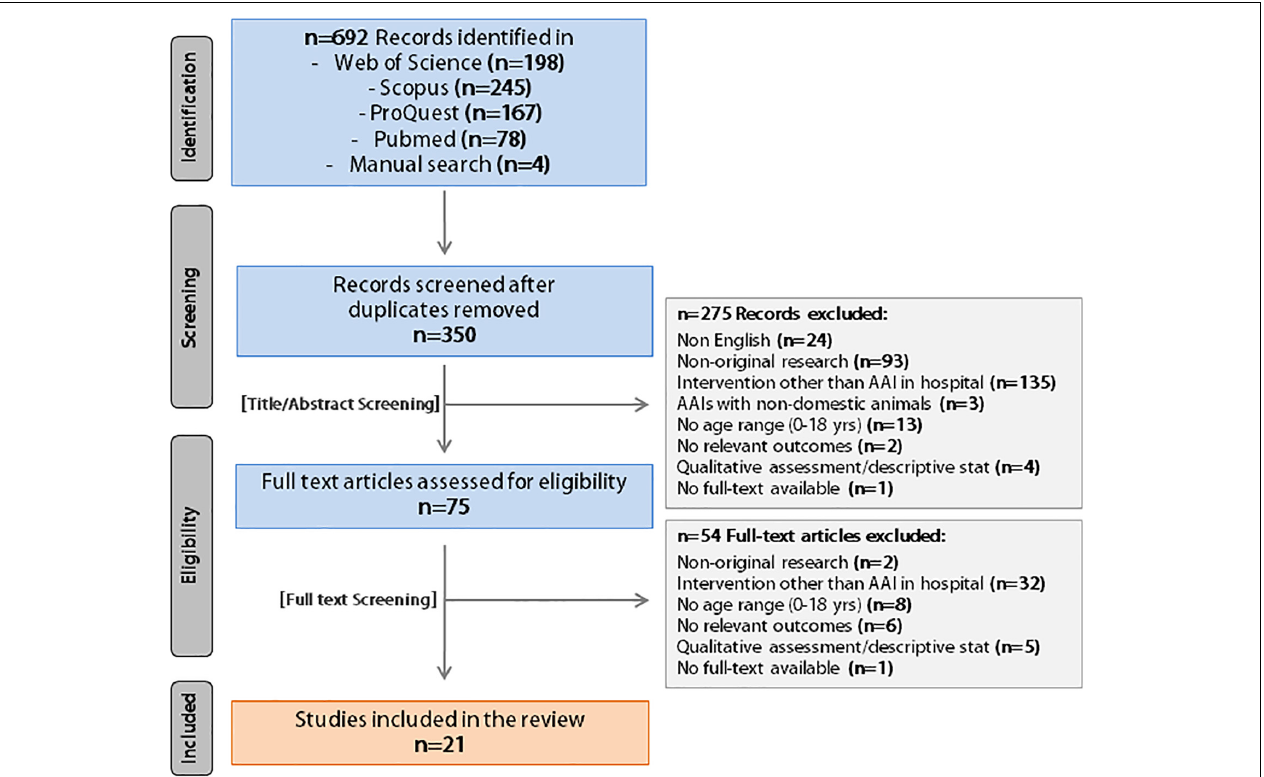
FIGURE 1 | PRISMA flow diagram of the literature search (identification) and selection process (screening, eligibility,